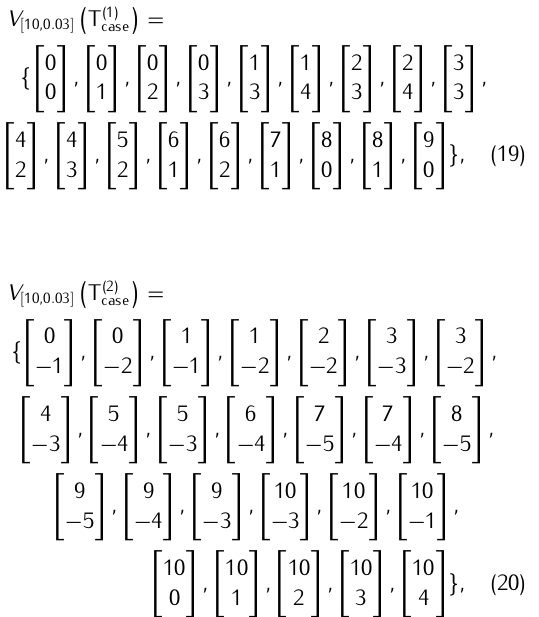
According to Fig. 5, the elements of the space X [10 , 0 . 03] cov- ered by the test cases T (1) case , T (2) case , T (3) case can be expressed in the following form (they are displayed in Fig. 5 using gray